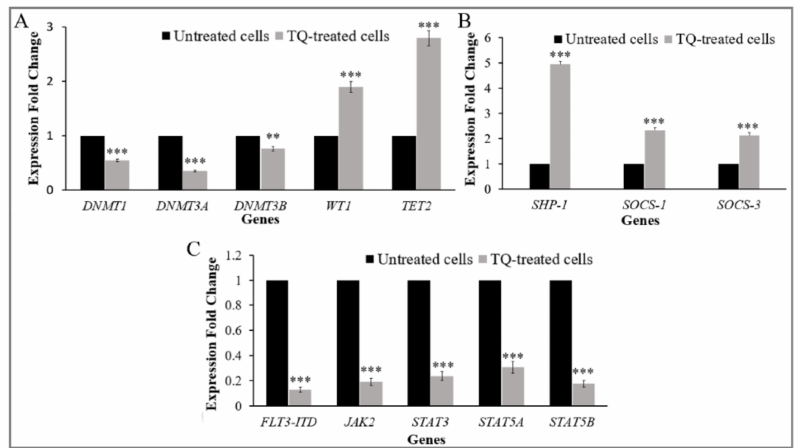
Figure 4. Effects of TQ on gene expression in MV4-11cells. Cells were treated with 5.5 µ M of TQ for 48 h. ( A ) The graph illustrates the downregulation of DNMT1 , DNMT3A , and DNMT3B and the up-regulation of TET2 and WT1 . ( B ) The graph shows the up-regulation of SHP-1 , SOCS-1 , and SOCS-3 . ( C ) The graph shows the downregulation of FLT3 -ITD, JAK2 , STAT3 , STAT5A , and STAT5B . Values are stated as median (interquartile range) (n = 3); where ** p < 0.01, *** p < 0.001 are significant versus untreated control cells.